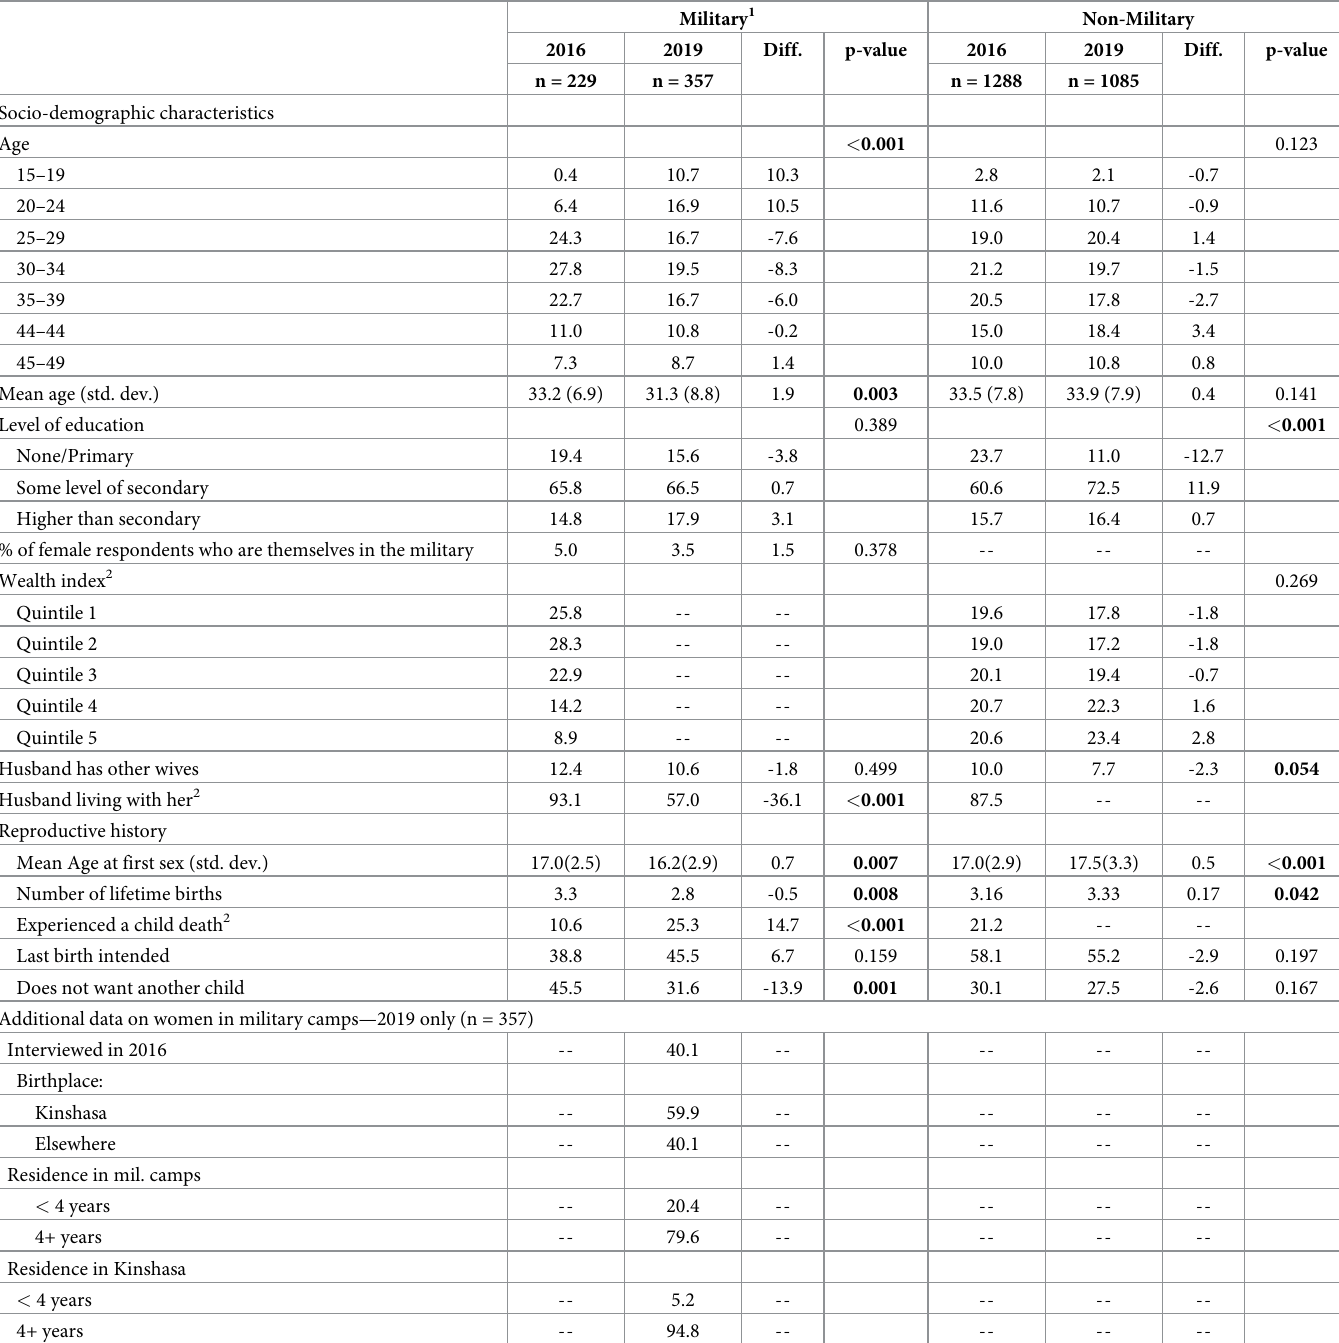
Table 1. Weighted background characteristics for military and non-military women, married or in union, Kinshasa 2016 and